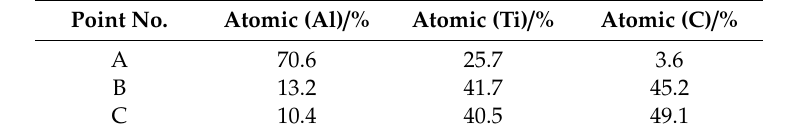
Figure 11. SEM images and map scan patterns of the quenched sample at 120 s: ( a ) SEM image; ( b ) SEM image of Area 1; ( c – e ) map scan patterns of Al, C, and Ti, respectively. Table 1. The energy dispersive spectrometer (EDS) composition analysis of point A, point B, and point C in Figure 11b.